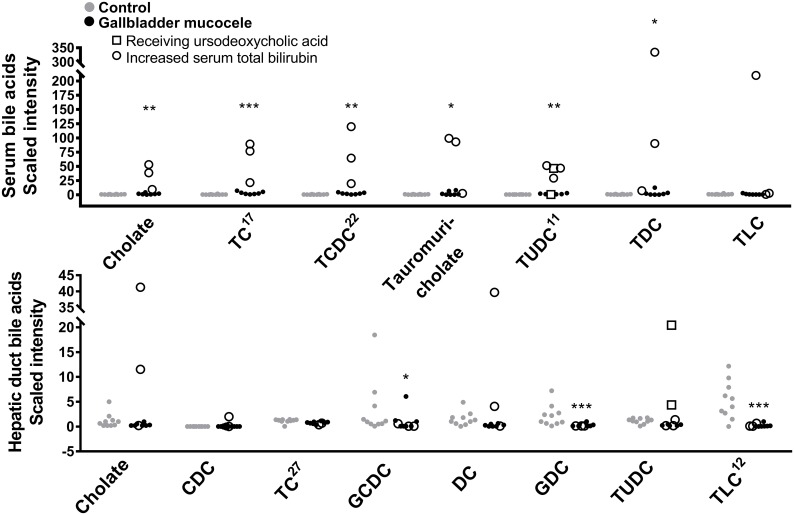
Compounds related to bile acid metabolism identified in the serum (top panel) and hepatic duct bile (bottom panel) of dogs with gallbladder mucocele formation compared to control dogs.Data points represent individual dogs. Dogs with mucocele formation and a concurrent increase in serum total bilirubin are designated with open circles. Superscript numbers, when present, indicate rank of the compound as identified by Random Forest analysis as able to distinguish between control dogs and dogs with gallbladder mucocele formation. *p<0.05, **p<0.01, ***p<0.001 Welch’s two sample t-test. TC, taurocholate; TCDC, taurochenodeoxycholate; TUDC, tauroursodeoxycholate; TDC, taurodeoxycholate; TLC, taurolithocholate; CDC, chenodeoxycholate; GCDC, glycochenodeoxycholate; DC, deoxycholate; GDC, glycodeoxycholate.